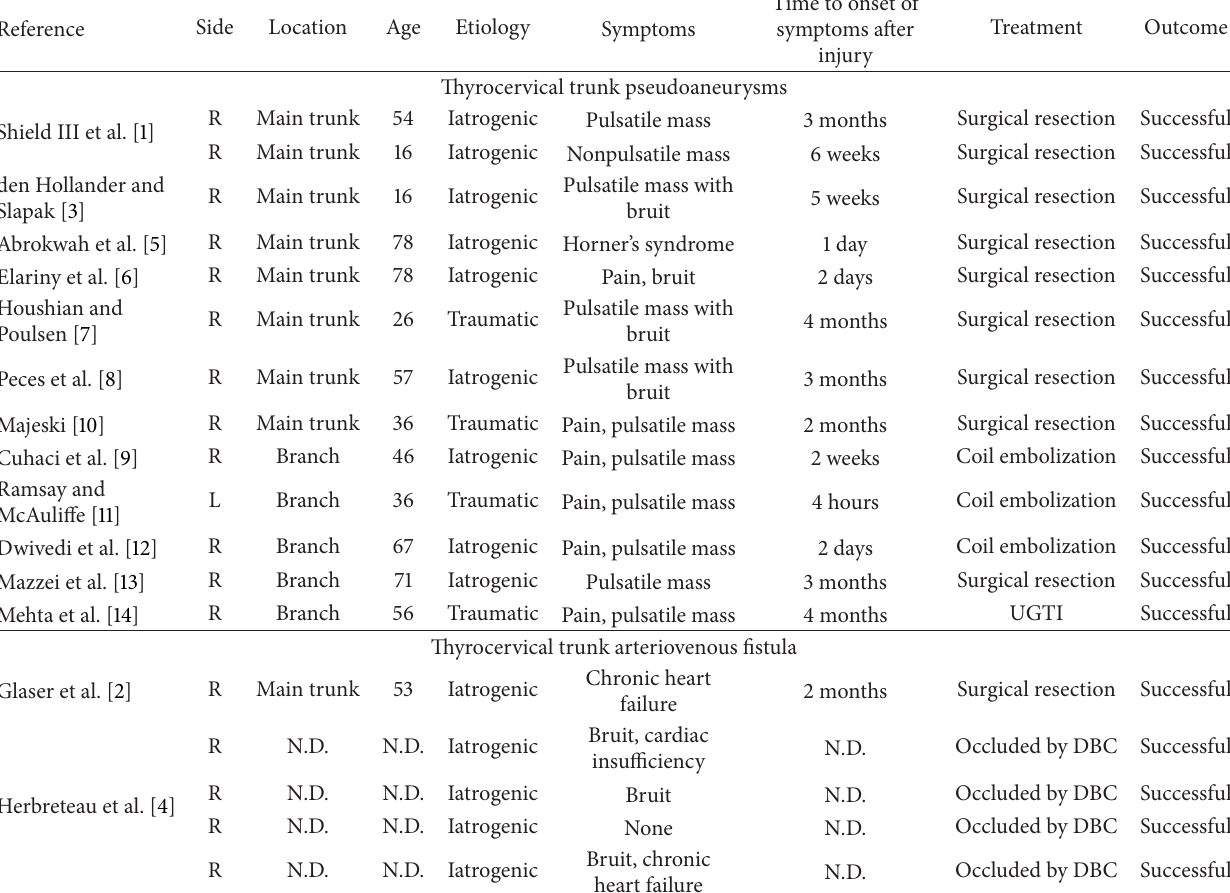
Table 1: Chart review of pseudoaneurysm and arteriovenous fistula of thyrocervical